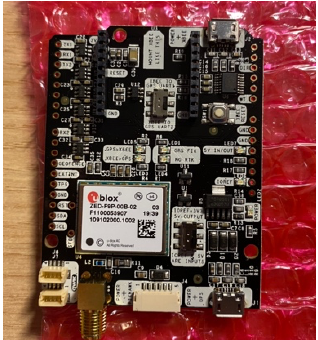
Figure 5: The external u-blox ZED-F9P GNSS